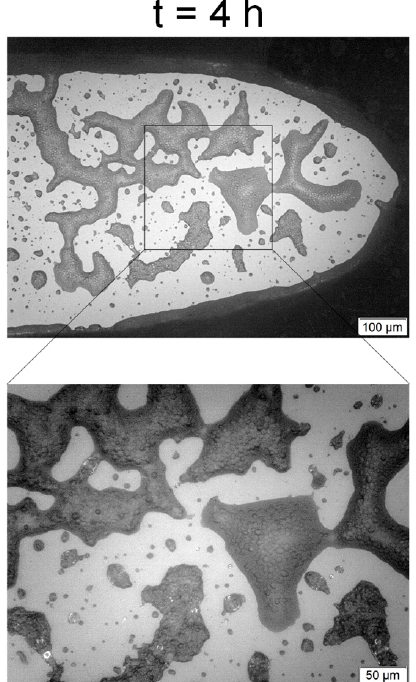
Figure 4. Square regions (2 × 10 − 5 mL) used for the visual estimation of the cell growth, for two different times: ( A ) t = 0 h; ( B ) t = 4 h. It is possible to observe in the inferior details of the increase in the number of dark points (left side of the square), which represents the S. cerevisiae cells.